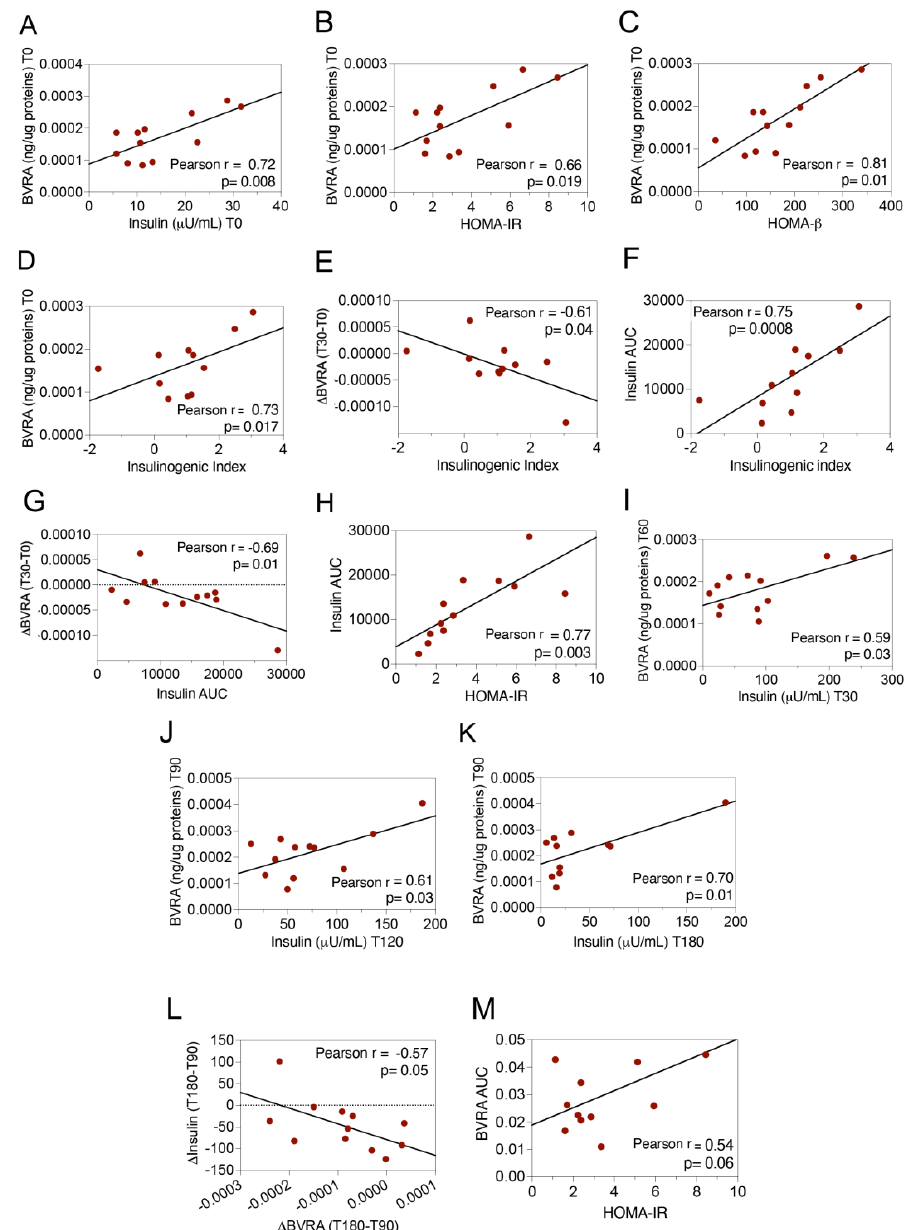
Figure 2. Significant correlations ( A – M ) found among BVRA protein levels in PBMCs, circulating insulin levels, and surrogate markers of insulin resistance (Pearson’s coefficient) in our cohort (N = 12).